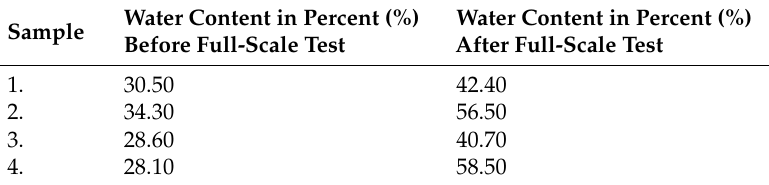
Table 1. Analysis of soil moisture of samples collected before and after the full-scale test. The results are given in precent (%) of water in the